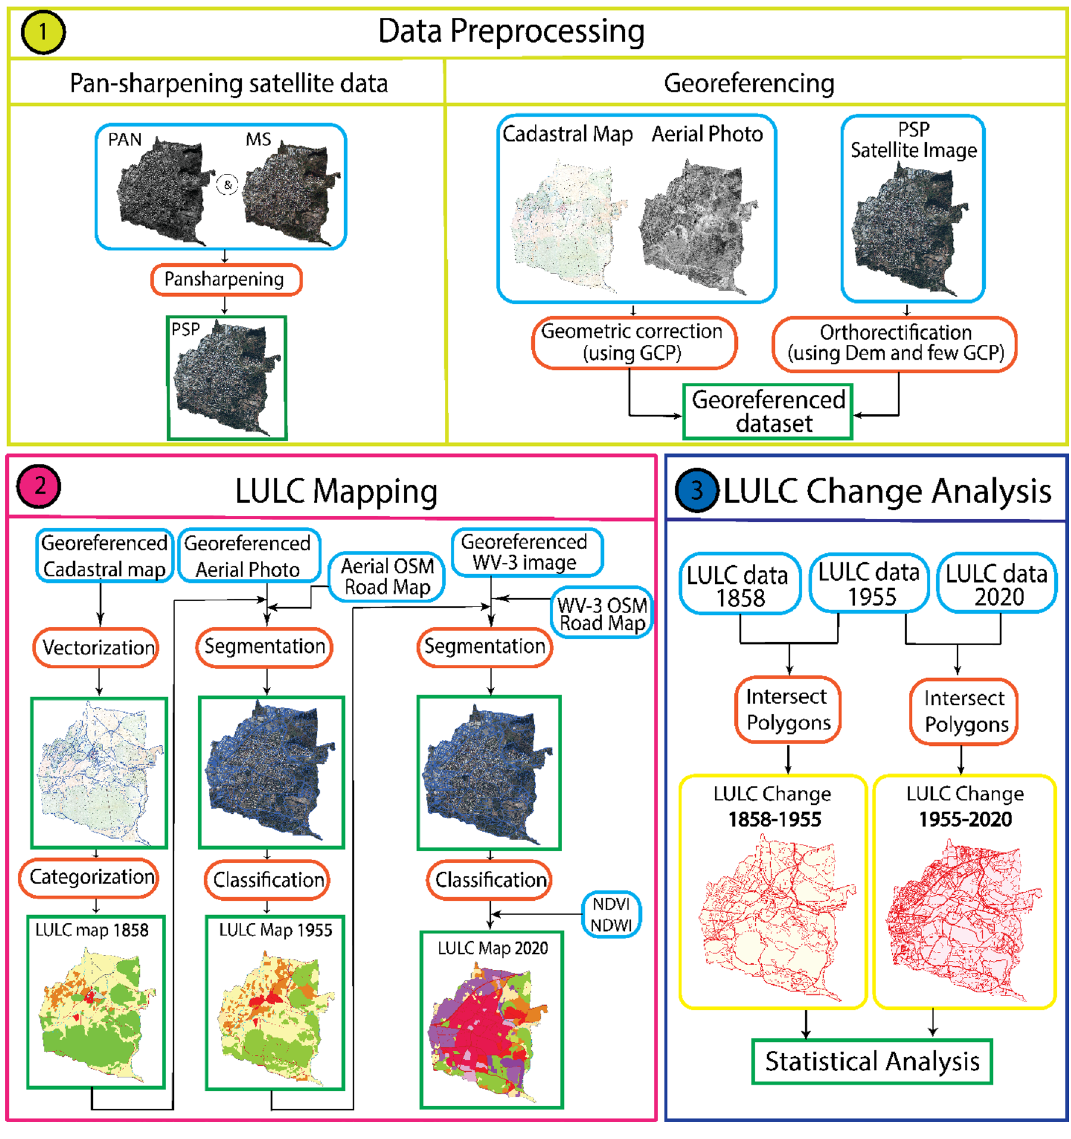
Figure 2. Flowchart of the processing steps for the LULC change analysis for